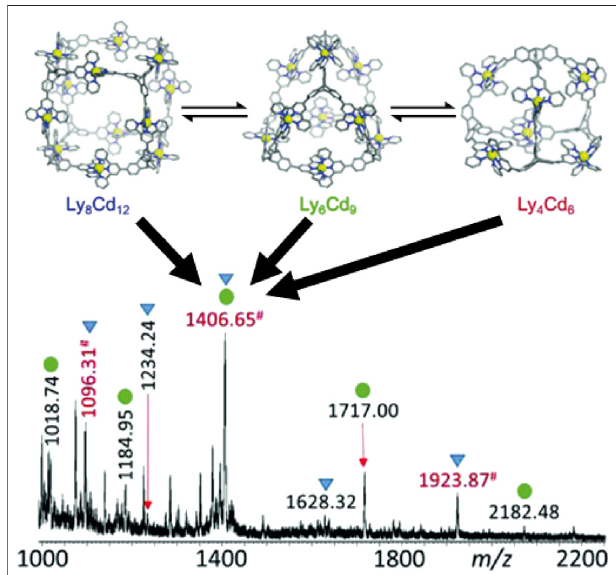
FIGURE 2 | An example of isobaric species occluding each other; the peak at m/z 1,406.65 is a combination of octomer, hexamer and tetramer structures of the same tris-terpyridine based ligand and cadmium (Endres et al., 2019).